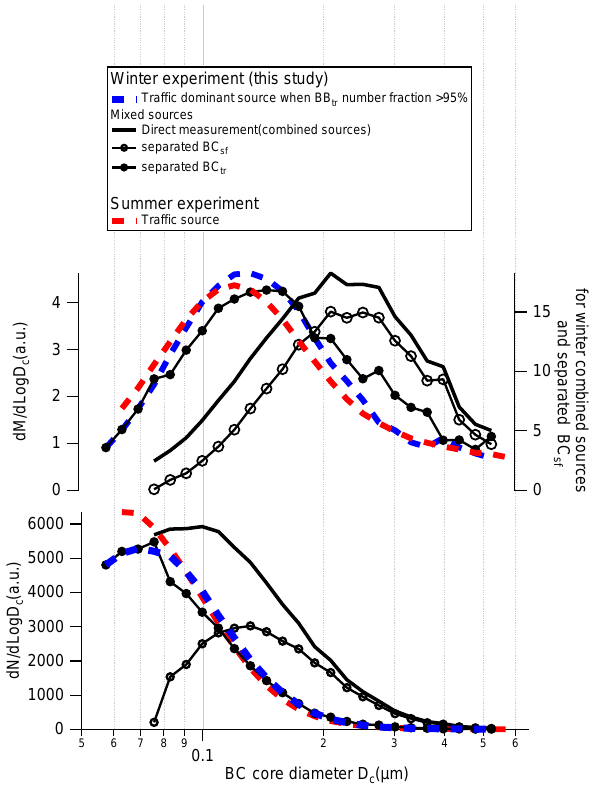
Figure 7. Mass and number size distributions of BC core: when traffic dominant source during winter; attributed BC tr and BC sf from mixed sources; and the BC in summer experiment when traffic source